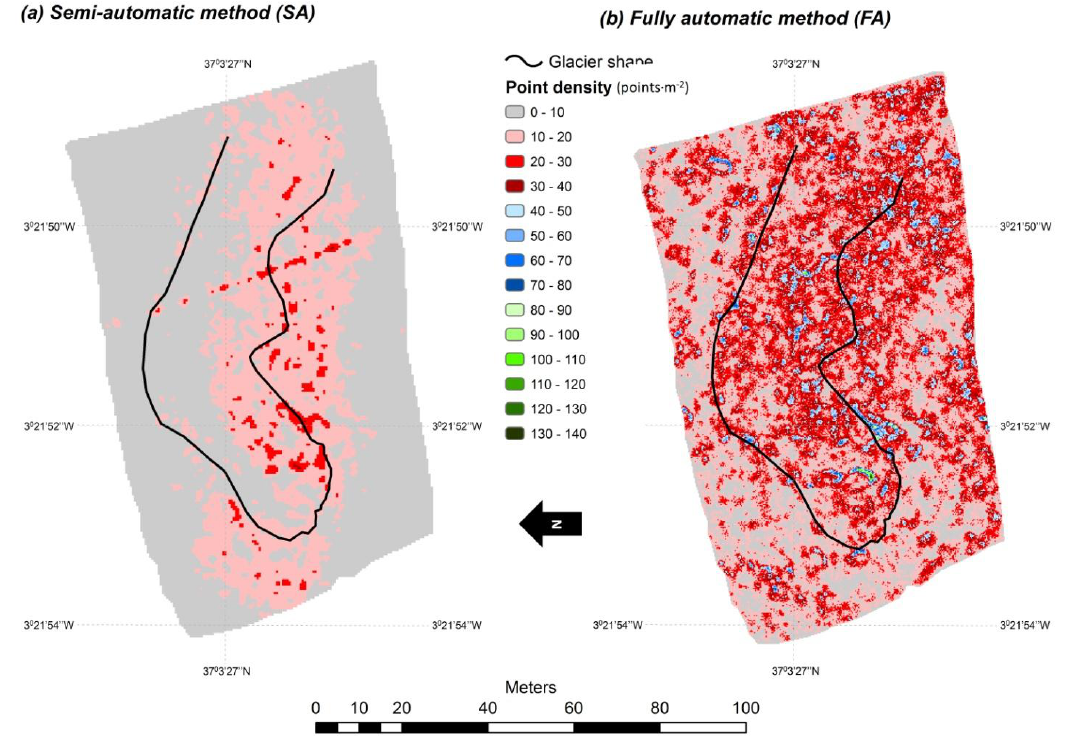
Figure 3. Horizontal point density for ( a ) the Semi-Automatic (SA) and ( b ) the Fully Automatic (FA) 3D photo-reconstruction